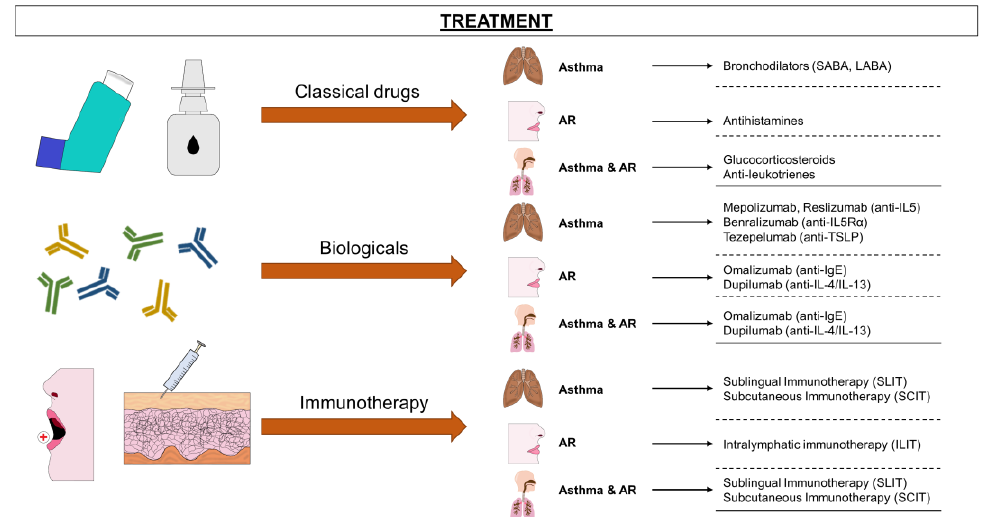
Figure 3. Therapeutic tools in asthma and AR. Traditionally, asthma and AR have been treated with classical drugs, such as bronchodilators, antihistamines, and corticosteroids. The form of administration of glucocorticoids is inhaled in asthmatic patients, while in patients with AR it is intranasal. However, in the last decades, the development of novel and more specific therapeutic tools such as biologicals and immunotherapy have permitted a more personalized medicine for asthma and AR.